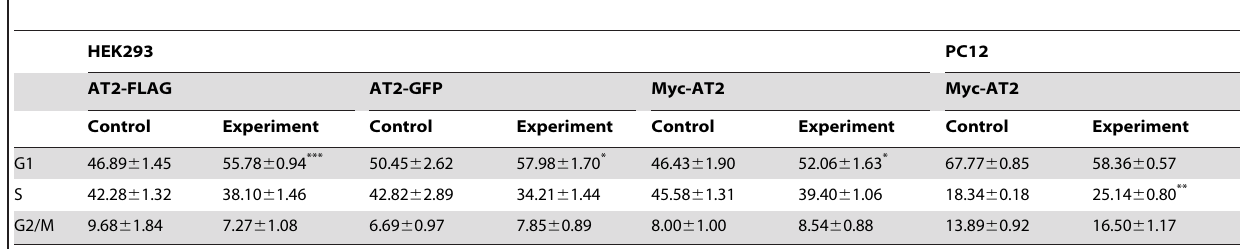
Table 2. Cell cycle profile of stable cell lines expressing epitope-tagged AT2 receptor